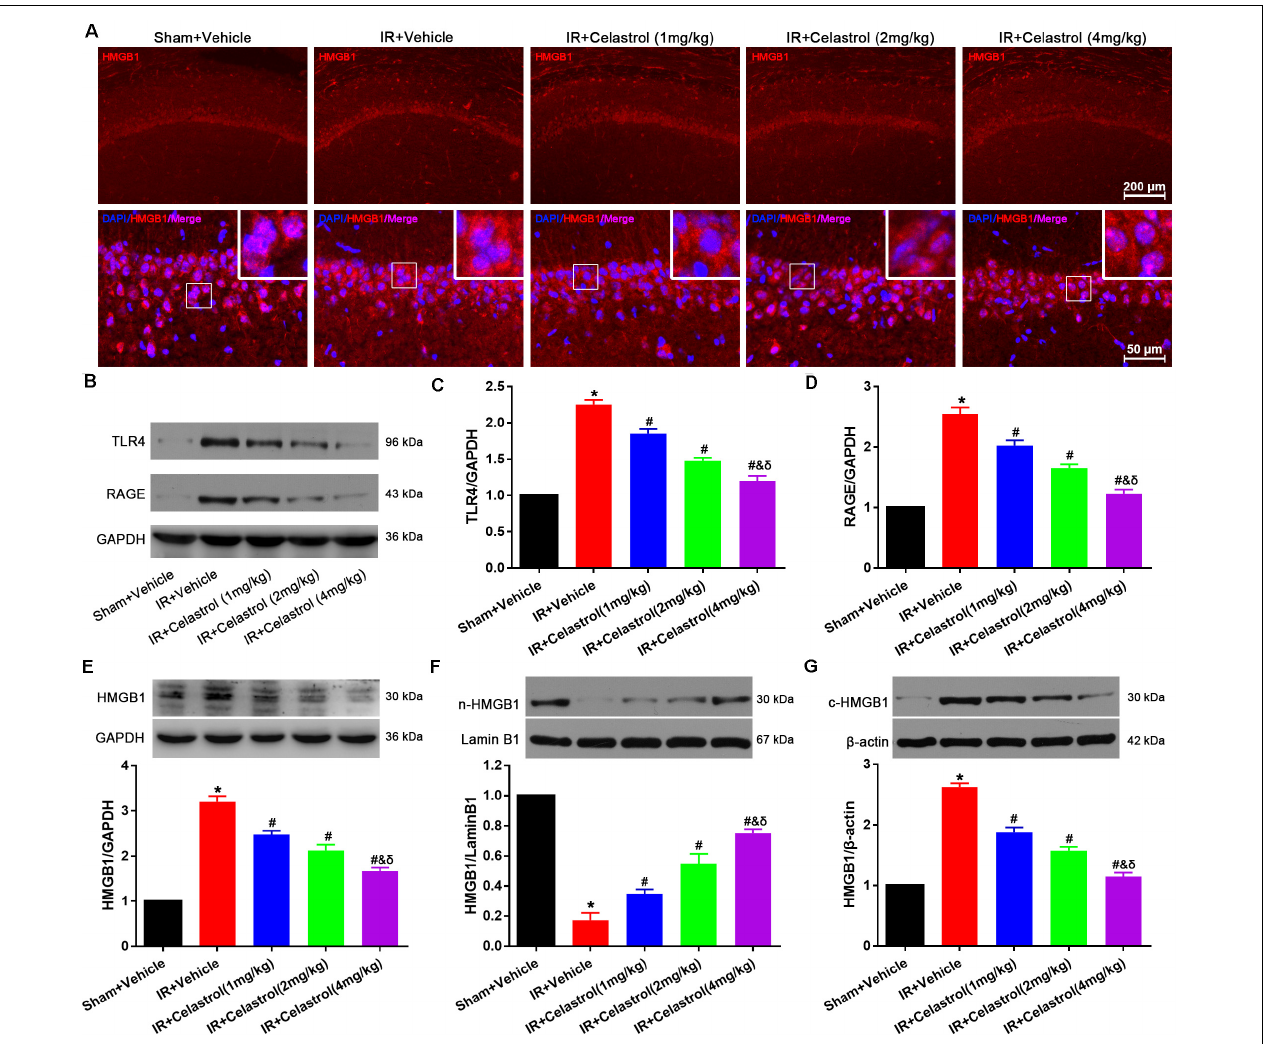
FIGURE 6 | Celastrol decreased HMGB-1, TLR4 and RAGE expression and rescued HMGB-1 translocation. (A) Representative immunofluorescent images of HMGB-1 in the hippocampus 3 days after tGCI/R, celastrol partially reversed tGCI/R induced HMGB1 nuclear-cytoplasm translocation. The upper right corner built-in thumbnails show the nuclear-cytoplasmic translocation of HMGB-1. Data were obtained from 4 independent animals, and the results of a typical experiment are presented. Red: HMGB1, blue: DAPI and scale bar = 200 µ m. (B–D) Representative western-blot images and quantitative analysis of TLR4 and RAGE in